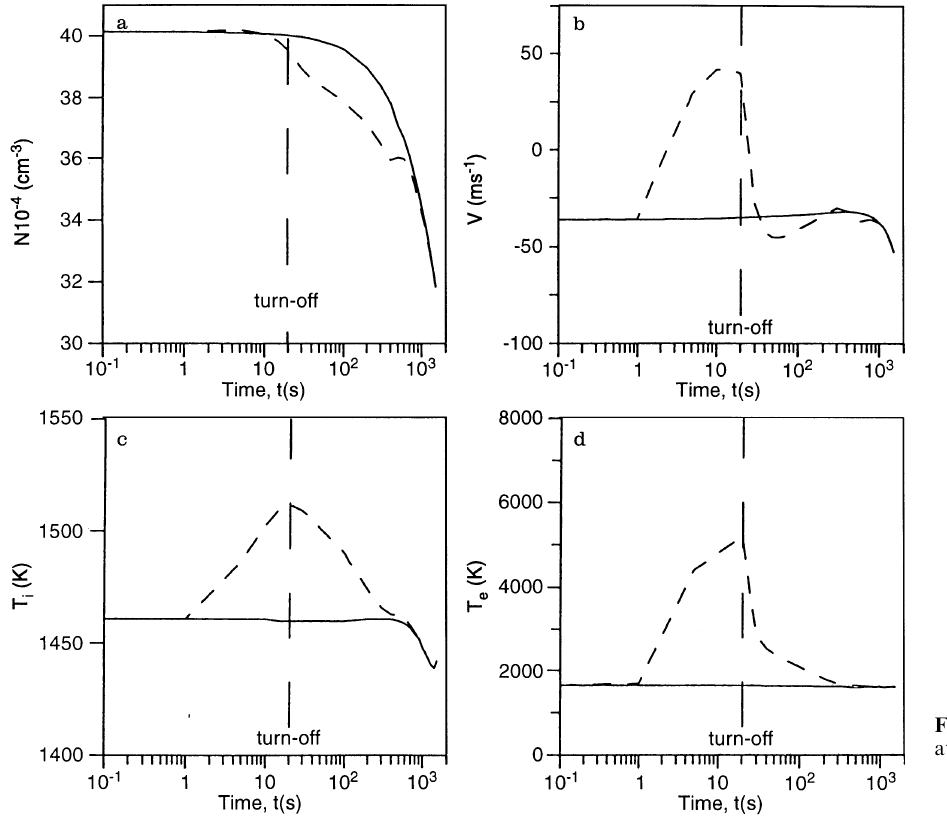
Fig. 5. The same as in Fig. 4 but at level h " 380